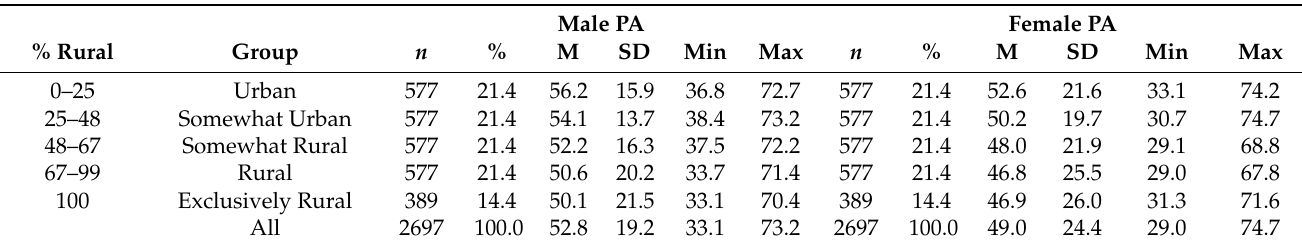
Table 2. Measures of Central Tendency for 2011 Male and Female County-level Prevalence of Meeting Physical Activity Guidelines. Male PA Female